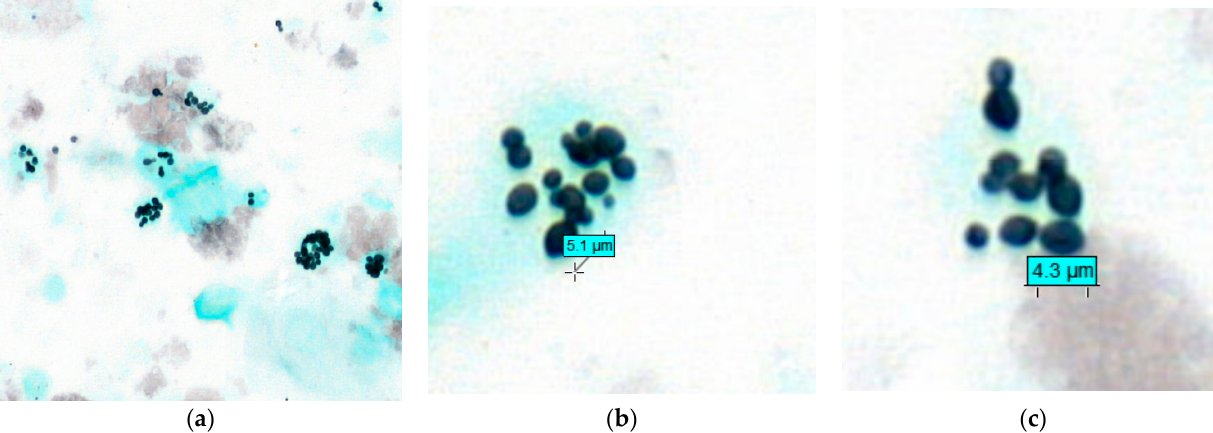
Figure 1. Bronchoalveolar lavage showing Histoplasma capsulatum . ( a ) Gomori-Grocott stain at ×40. H. capsulatum appears as small spherical or ovoid yeasts <6 µm in size. After inhalation, it makes a dimorphic transition to yeast, enters macrophages, and is then able to proliferate and survive intracellularly, and sometimes extracellularly. ( b , c ) Gomori-Grocott stain at ×100 and ×120, respectively.